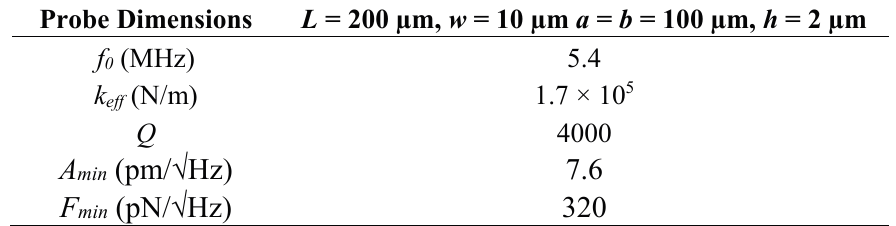
Table 1. Minimal detectable force F min deduced for dog-bone AFM